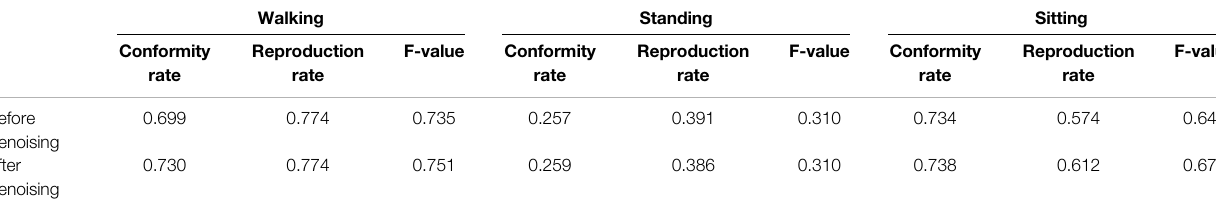
TABLE 4 | F-value after denoising. Walking Standing Sitting Conformity Reproduction F-value Conformity Reproduction F-value Conformity Reproduction rate rate rate rate rate rate